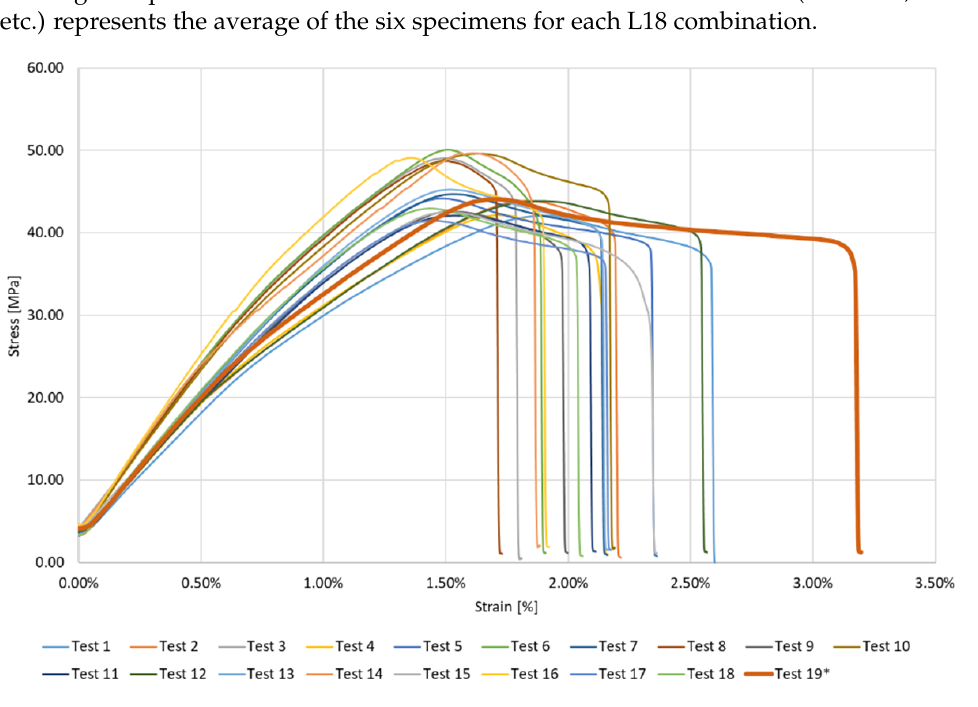
Figure 7. Stress-strain for tensile strength.